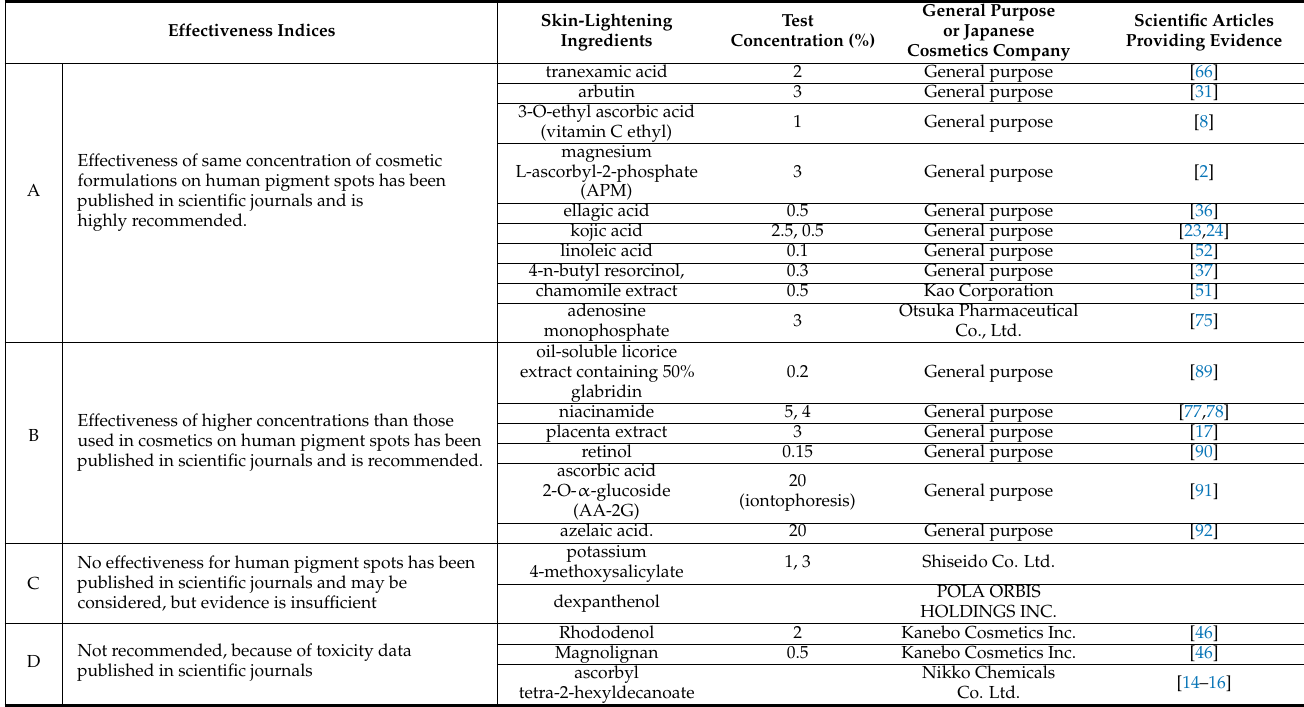
Table 3. Effectiveness indices of lightening ingredients developed in